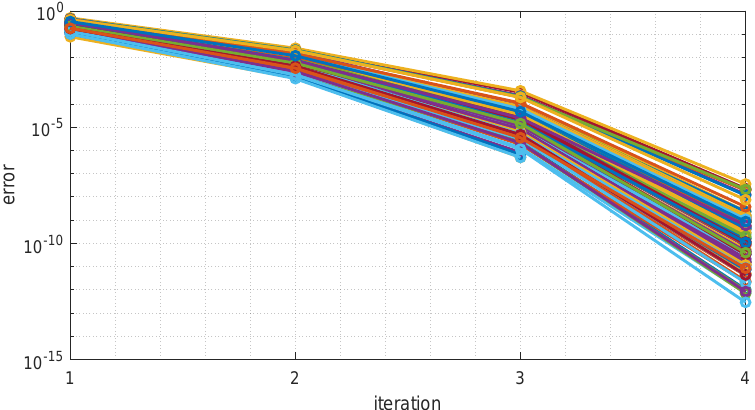
Figure 7. Error vs. iteration of proposed algorithm of 100 randomly selected